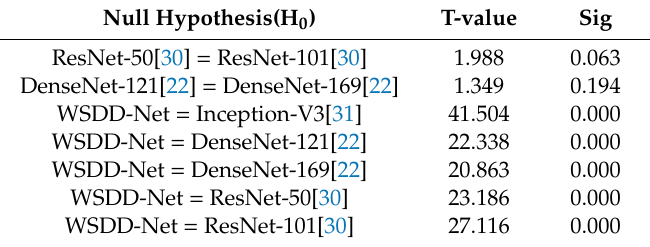
Figure 7. Test results from the wildfire smoke (WS) dataset. ( a ) Box-plot for 10 AR values of each method and ( b ) box-plot for 10 FAR values of each method. Table 2. Statistical significance of performance comparisons.